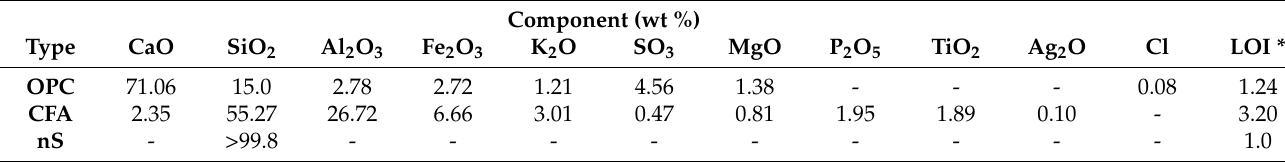
Table 1. Chemical composition of binders.